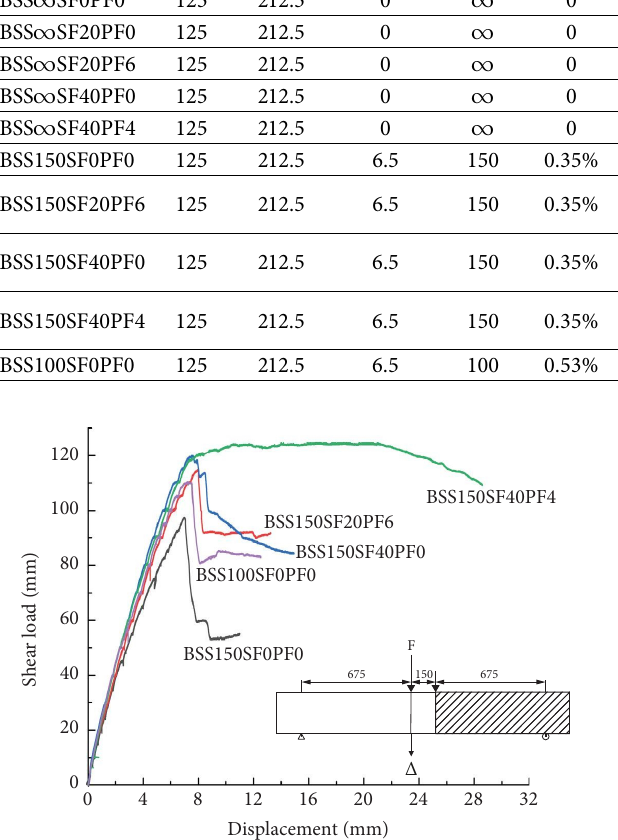
Table 4: Ultimate shear load and ultimate displacement at load point. Beam no.